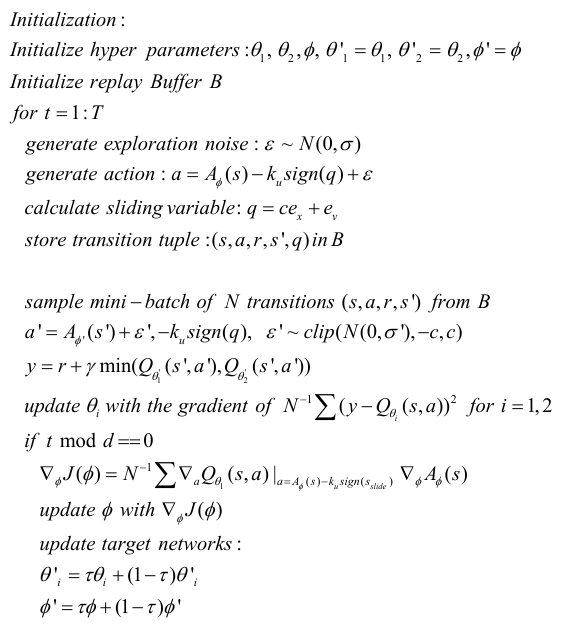
Figure 3. Pseudo-code for the sliding mode TD3.